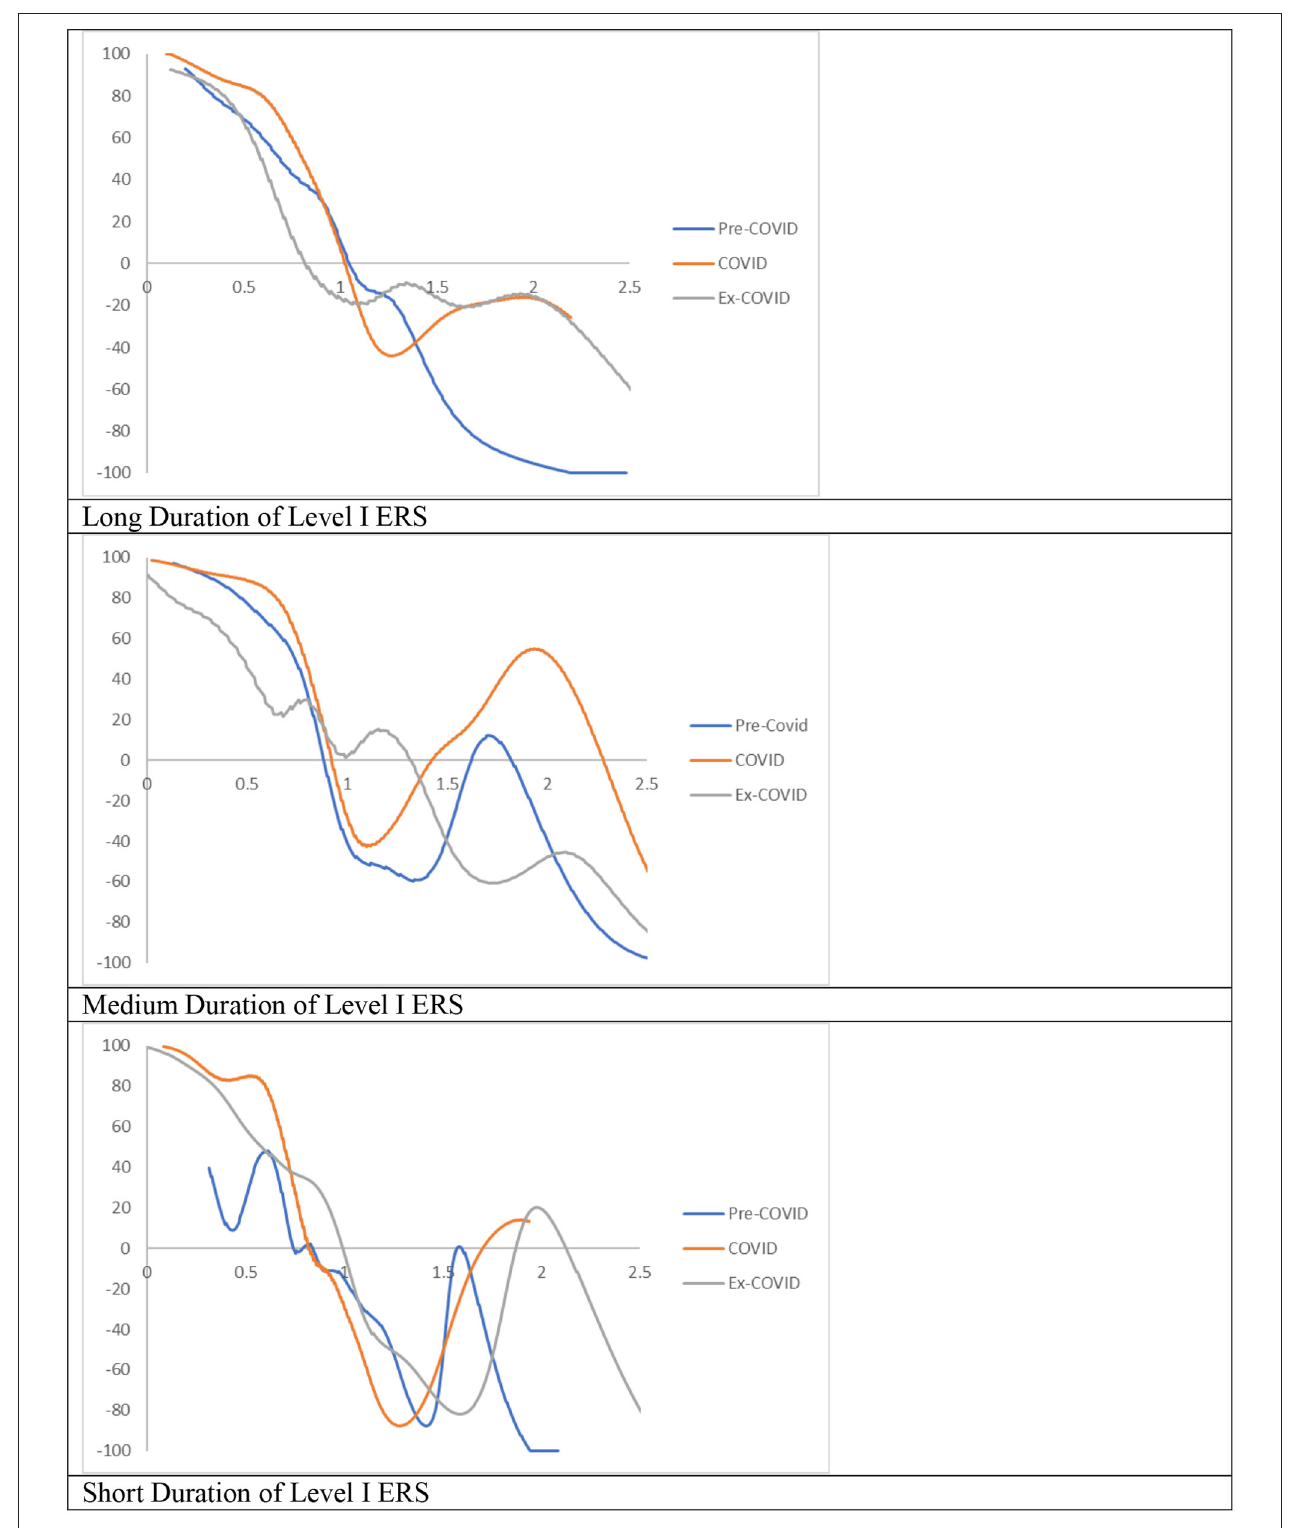
FIGURE 12 | Mobility probability plot (MPP) for the RDIPC of rural residents in cities with long, medium, and short duration of Level I ERS with quarterly transitions. Source: authors’ calculation. N.B. The vertical axis indicates net upward mobility (%) and the horizontal axis indicates RDIPC values.